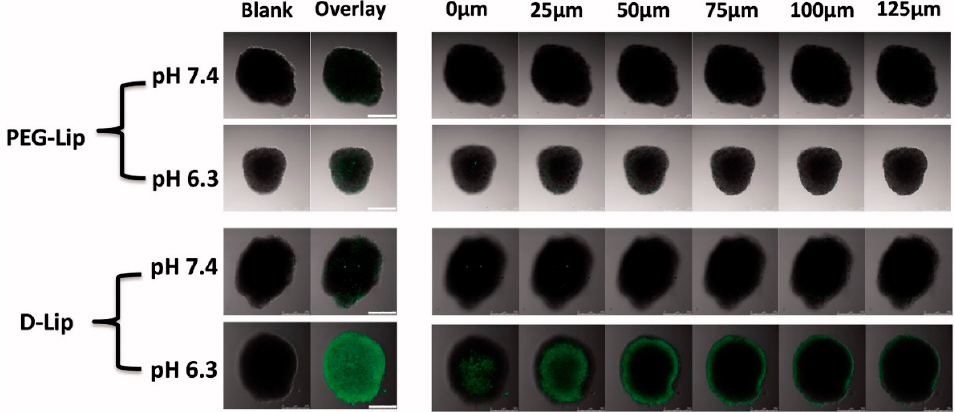
Figure 8. The uptake of CFPE-labeled D-Lip under both pH 7.4 and 6.3 within different depths into the tumor spheroid. The scale bars represent 250 μ m [89] (Reprinted with permission from [89]).